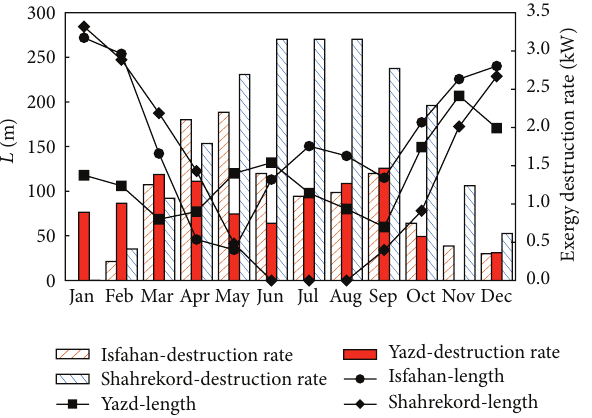
Figure 16: Monthly GSHX minimum required length and system exergy destruction rate.